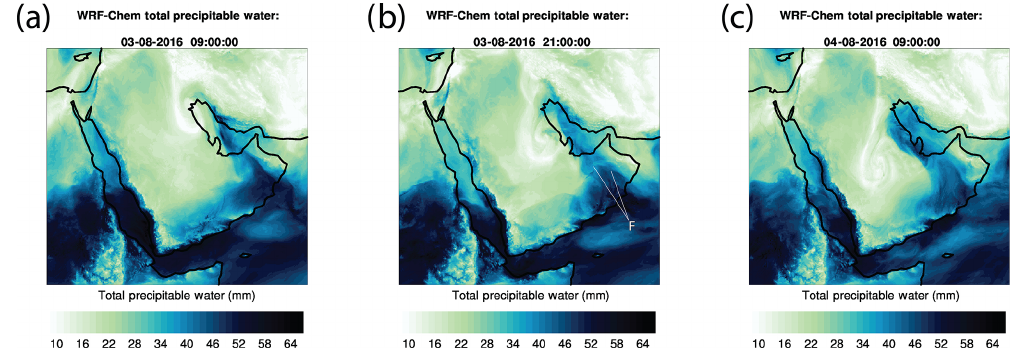
Figure 8. As in Fig. 3 but showing total precipitable water (TPW; mm). The frontal feature denoted in Fig. 3b and discussed in Sect. 3.3 is shown again here as “F” in panel (b) .